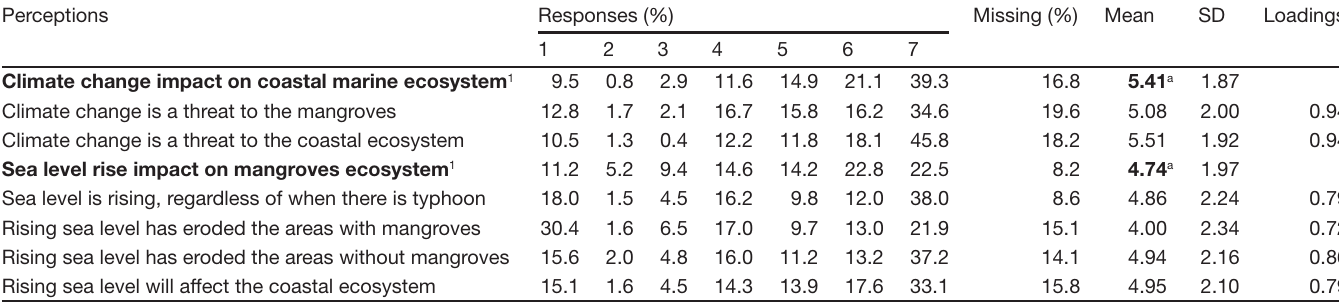
Table A1. Perceptions of climate change impact in the coastal areas. The response options provided to the respondents was a bipolar rating scale: 1 = fully disagree to 7 = fully agree. n = 291 Perceptions Responses (%) Missing (%) Mean